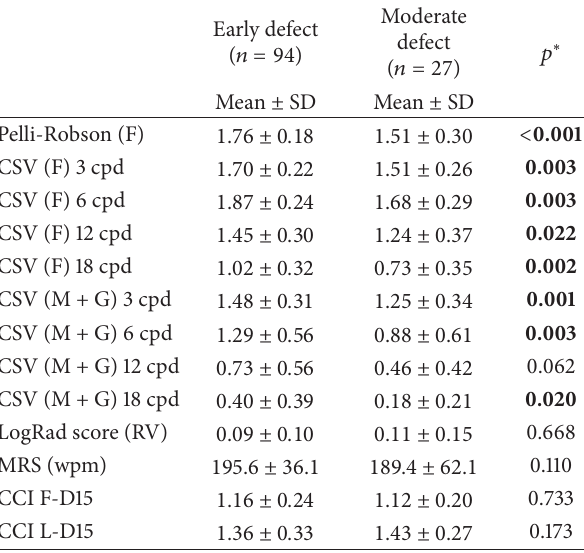
Table 3: Mean and standard deviation obtained in visual function tests with subjects classified into two groups according to disease severity (Hodapp-Parrish-Anderson